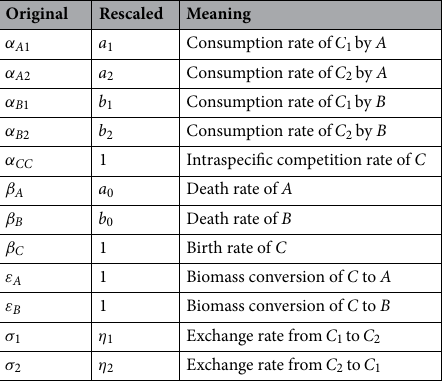
Table 1. Model parameters (before/after rescaling) and their meanings.